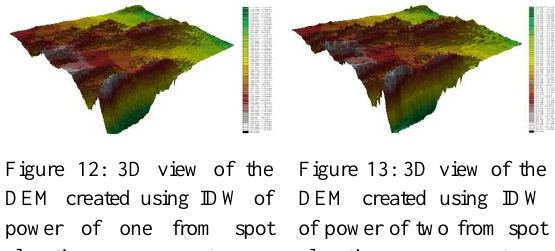
Figure 19: 3D view of the DEM created using IDW of power of eight from spot elevation measurements.